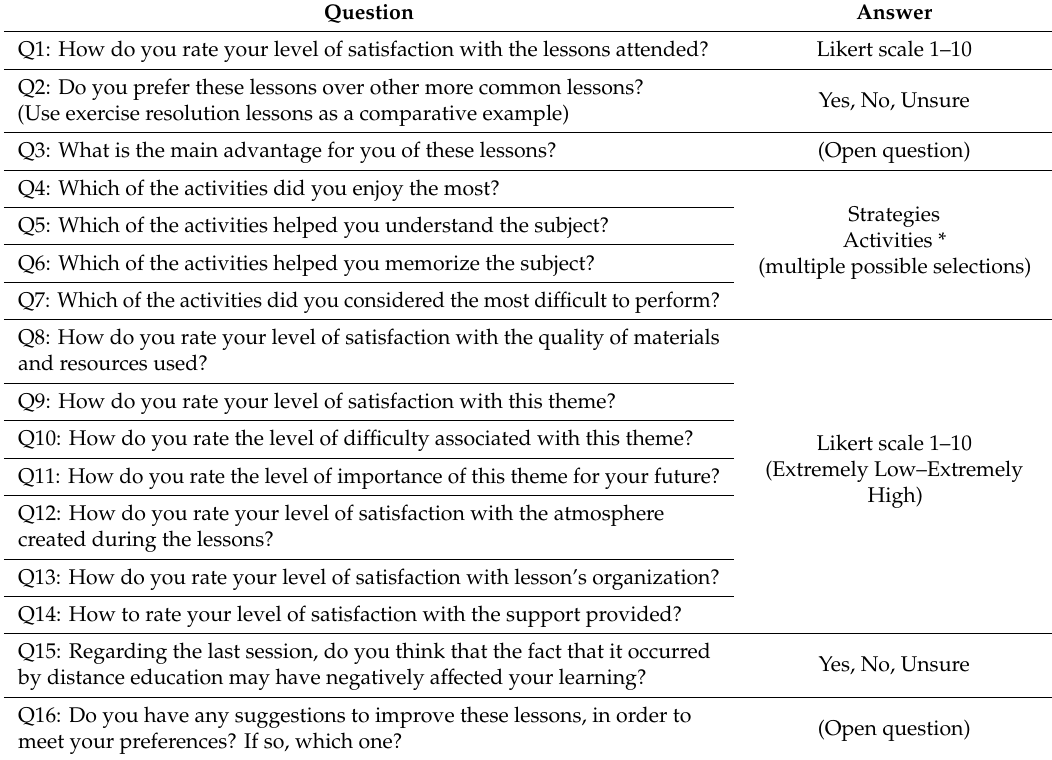
Table 3. Questions composing the final questionnaire and respective answer